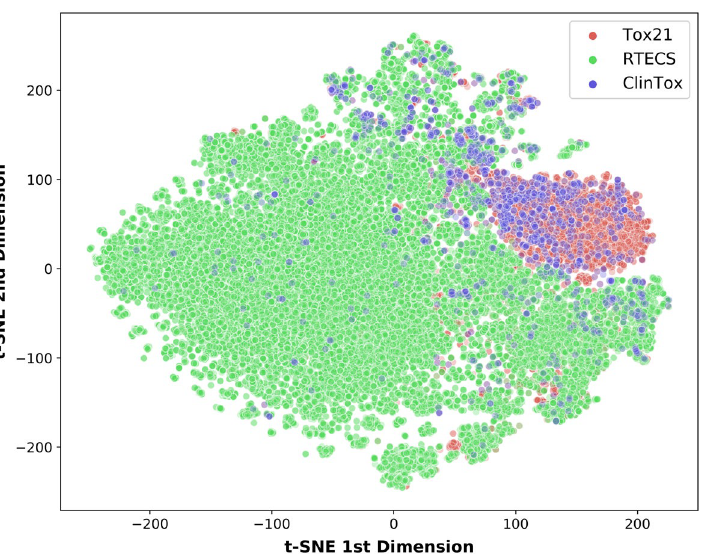
Figure 5. t-SNE of SMILES embeddings of chemicals in the Tox21, RTECS, and ClinTox datasets. Distances correlate to similarities of the chemicals across these datasets; shorter the linear distance, the more similar are the chemicals. ClinTox chemicals overlap more with Tox21 chemicals than with